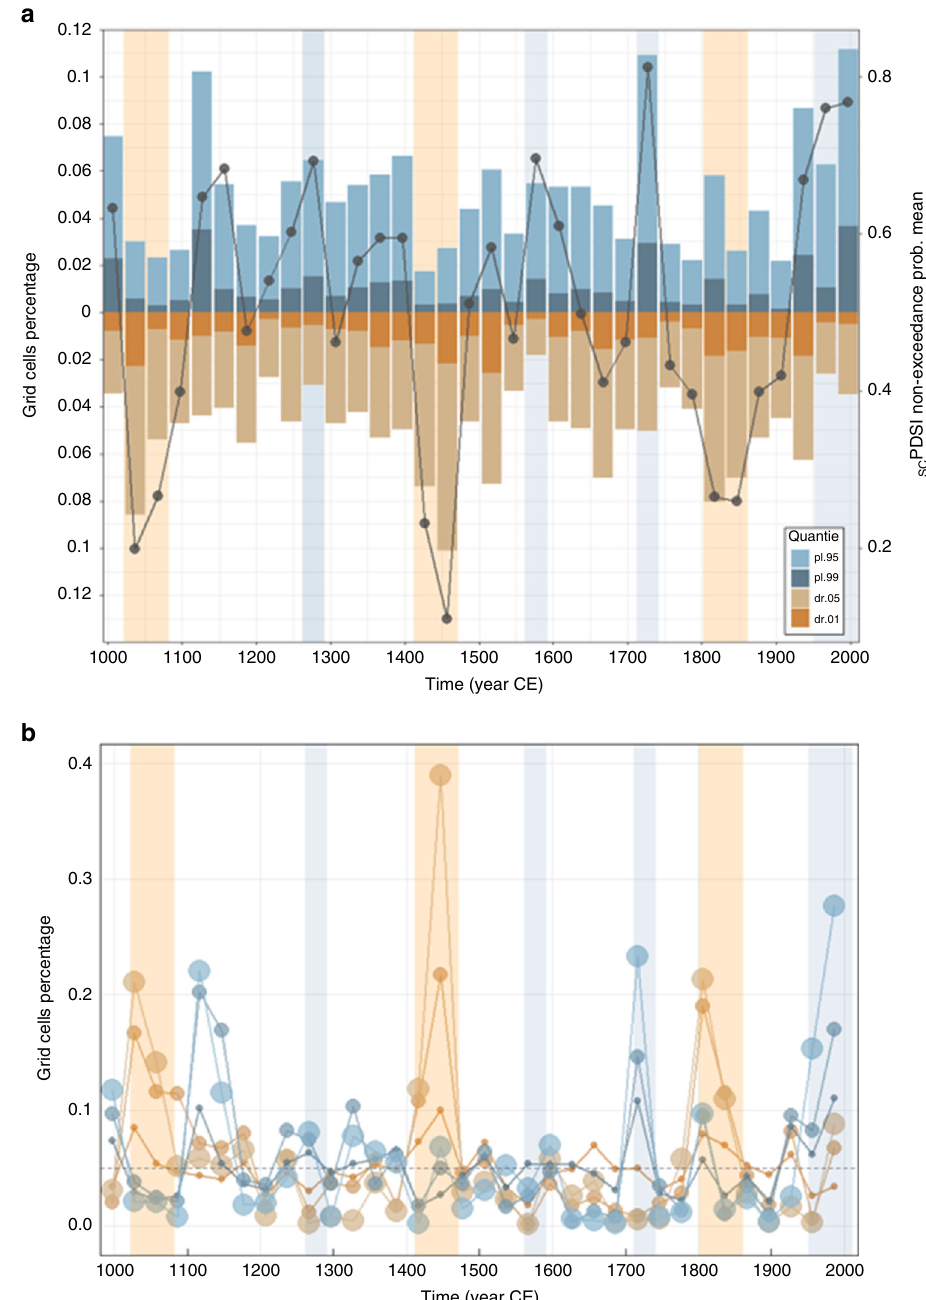
Fig. 1 Long-term hydroclimatic change over Europe. a Mean of the non-exceedance probability (MNP) of the scPDSI for Europe at 30-year scale (black circled line) and percentage of grid cells with scPDSI in the top/bottom 0.05 and 0.01 quantiles per 30-year periods (blue and brown bars). Light orange and blue areas correspond to droughts and pluvials in the 30-year scale. b Percentage of grid cells with scPDSI in the top (bottom) 0.95 (0.05) quantile per 1-, 10- and 30-year period (blue and brown circles; size corresponds to scale, i.e., the smallest are in annual scale). Grey dashed line represents the nominal quantile